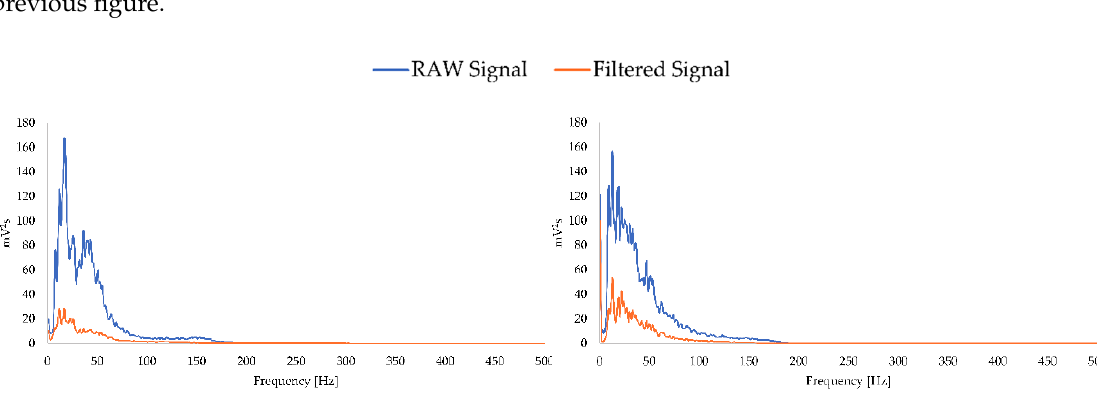
Figure 5. Signal spectrum of the EMG signal before and after filtering. The example on the left comes from a female who is 24 years old, exercises 3 h a week and has a BMI of 24, and the example on the right comes from a male who is 23 years old, exercises 3 h a week and has a BMI of 23.6. Once the signal was filtered, the MAV, RMS and MNF indicators were assessed by means of a